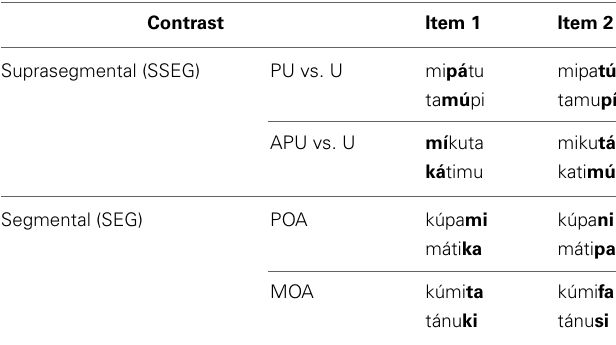
Table 1 | Stimuli for the segmental and suprasegmental